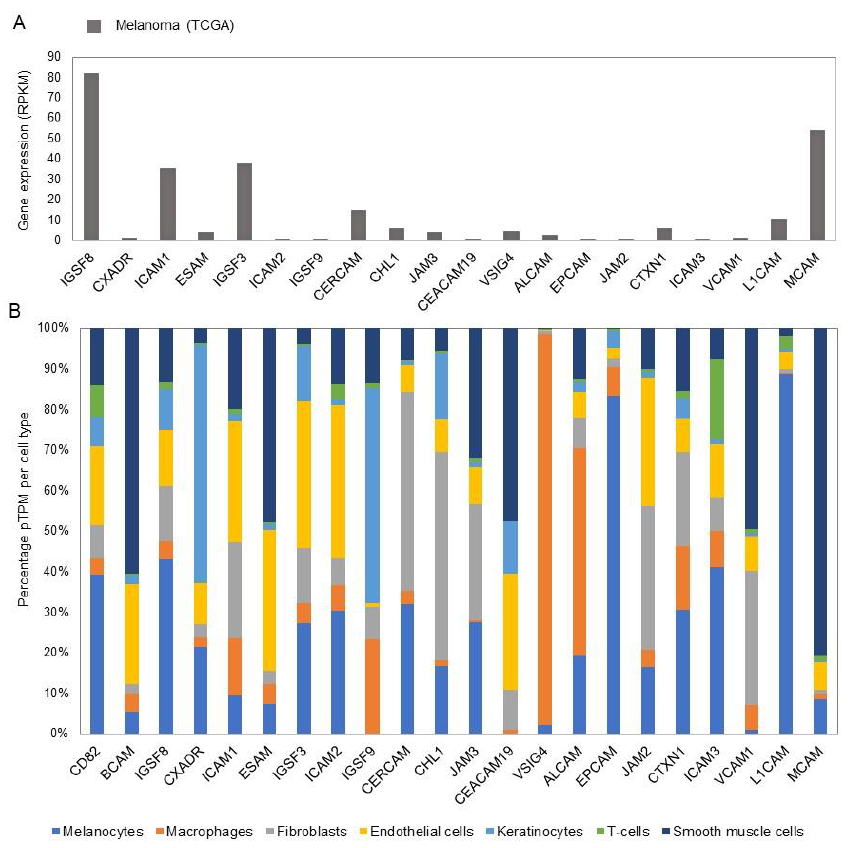
Figure 6. Gene expression of IgSF CAMs in melanoma cells and different cell types of healthy human skin. ( A ) Expression of IgSF CAM genes in metastatic melanoma cells from single-cell RNA-seq experiments (Tirosh et al., 2016). ( B ) Expression of IgSF CAM genes in different cell types of healthy human skin from single-cell RNA-seq experiments (Sole-Boldo et al., 2020), where expression values of clusters of similar cell types were merged. See also Table S3.